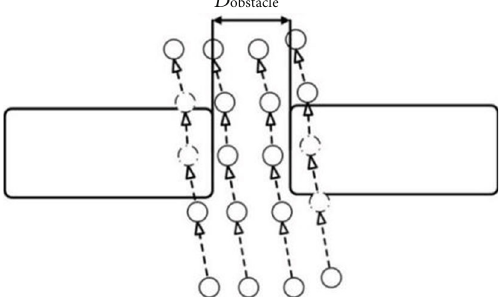
Figure 8: The crowd through the obstacles.